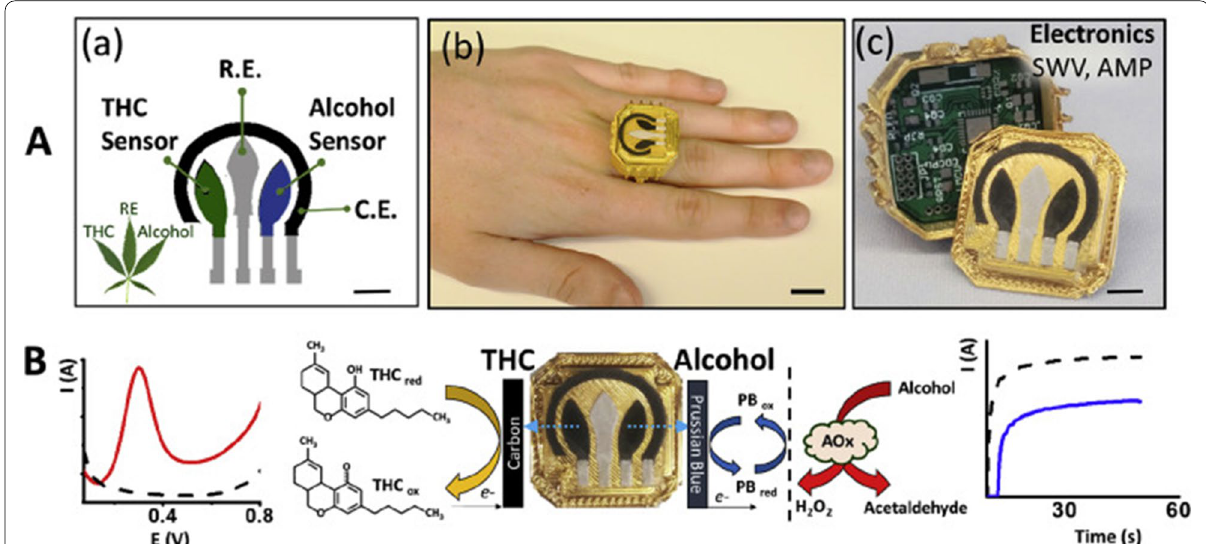
Fig. 5 A (a) The sensor designed by Mishra et al. for simultaneous detection of THC and alcohol. (b) The image of ring-shaped sensor. (c) The ring polymeric case with the embedded electronics and replaceable screen-printed electrodes section. B Mechanisms of THC and alcohol detection using the ring sensor. The voltammogram for the detection of THC (in red) and the amperogram of alcohol detection is also illustrated (in blue). Taken from (Mishra et al. 2020) with permission from Elsevier (Copyright